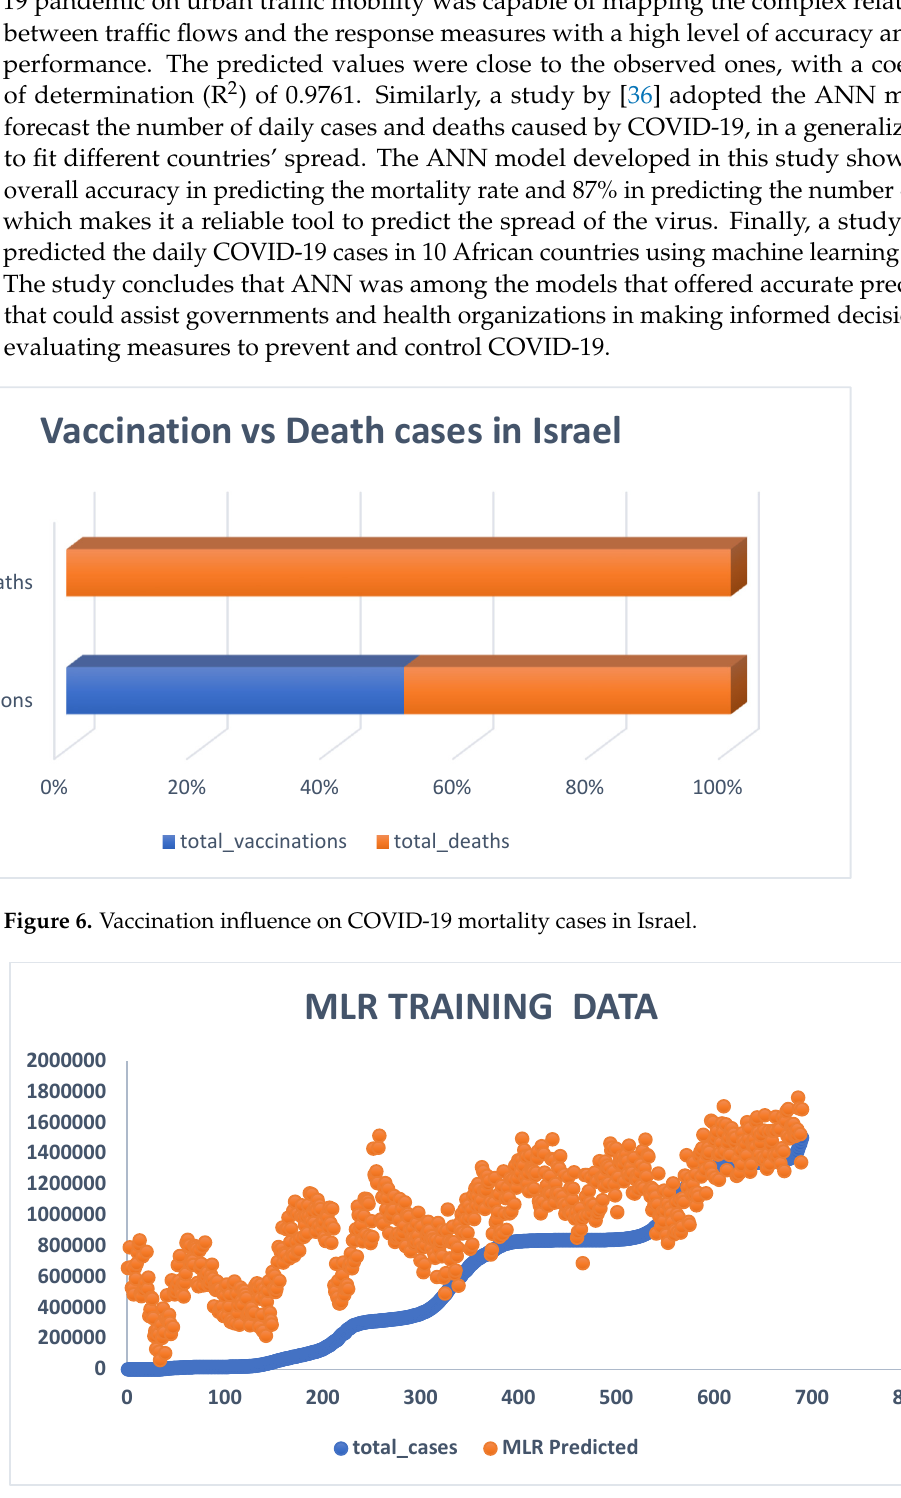
Figure 7: MLR training data showing experimental and predicted values. Figure 7. MLR training data showing experimental and predicted